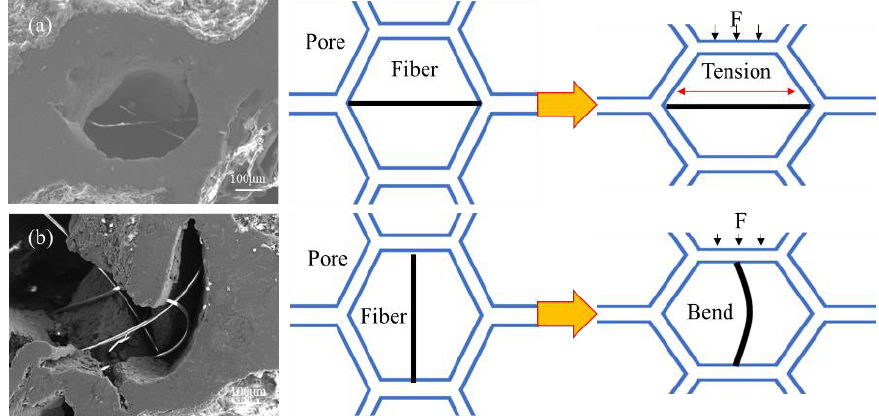
Figure 9. Deformation and load of BF during compression and its schematic diagram: ( a ) Tensile; ( b ) bend.